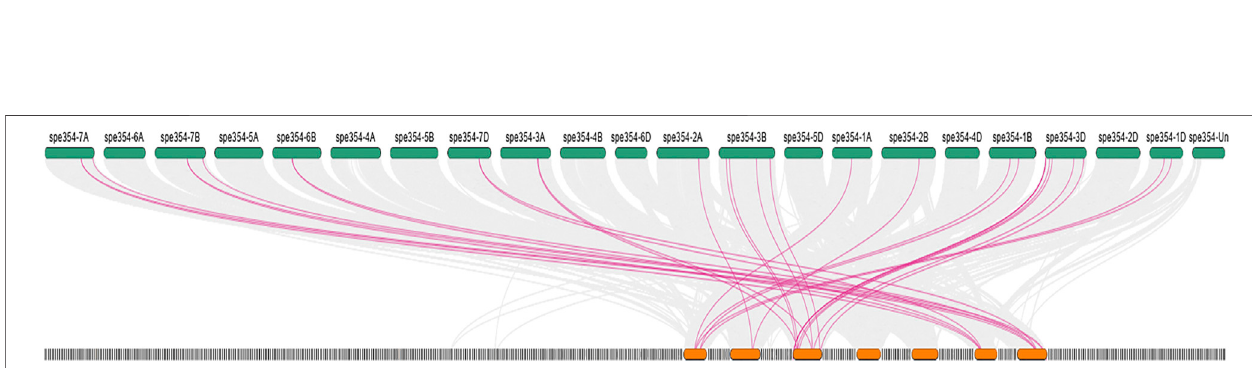
Frontiers in Genetics |